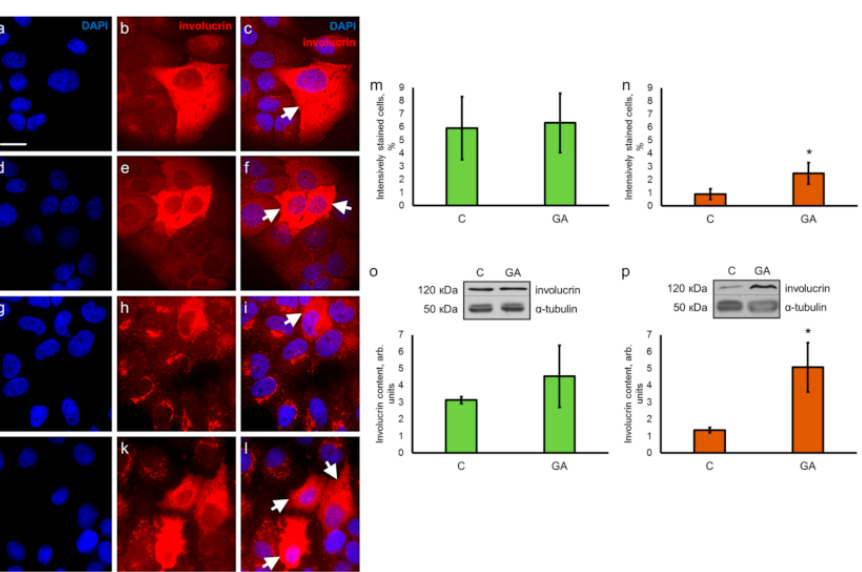
Figure 4. Immunocytochemical visualization and evaluation of involucrin content in keratinocytes HaCaT and carcinoma A431 cells. ( a – f ) Keratinocytes HaCaT in control specimens ( a – c ) and in the presence of GA ( d – f ), arrowheads indicate brightly stained cells; ( g – l ) carcinoma A431 cells in control specimens ( g – i ) and in the presence of GA ( j – l ); arrowheads indicate cells with bright diffuse staining of the cytoplasm; note that involucrin-positive tubular/vesicular structures are seen in the cells with faintly stained cytoplasm. Nuclei are stained with DAPI (left column), involucrin-positive staining is detected with anti-involucrin antibodies (middle column), merged images (right column). Scale bar, 20 µ m. The relative number of cells with brightly stained cytoplasm in control specimens versus GA treated samples is shown in ( m ) (HaCaT cells) and ( n ) (A431 cells). Data are shown as mean ± standard deviation ( n = 3); * p ≤ 0.01 according to the Mann–Whitney test. Western blot analysis and evaluation of involucrin content in HaCaT ( o ) and A431 cells ( p ). C—cells growing with ethanol as a solvent for GA (control for GA). Data are shown as mean ± standard deviation ( n = 3); * p ≤ 0.05 according to the Mann–Whitney